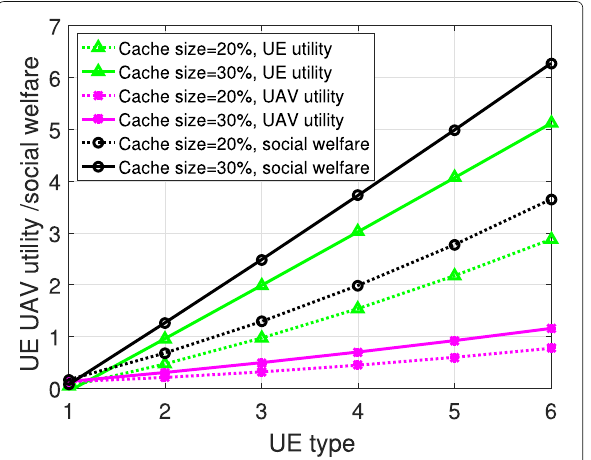
Fig. 4 UE and UAV utility, and social welfare versus the UE type